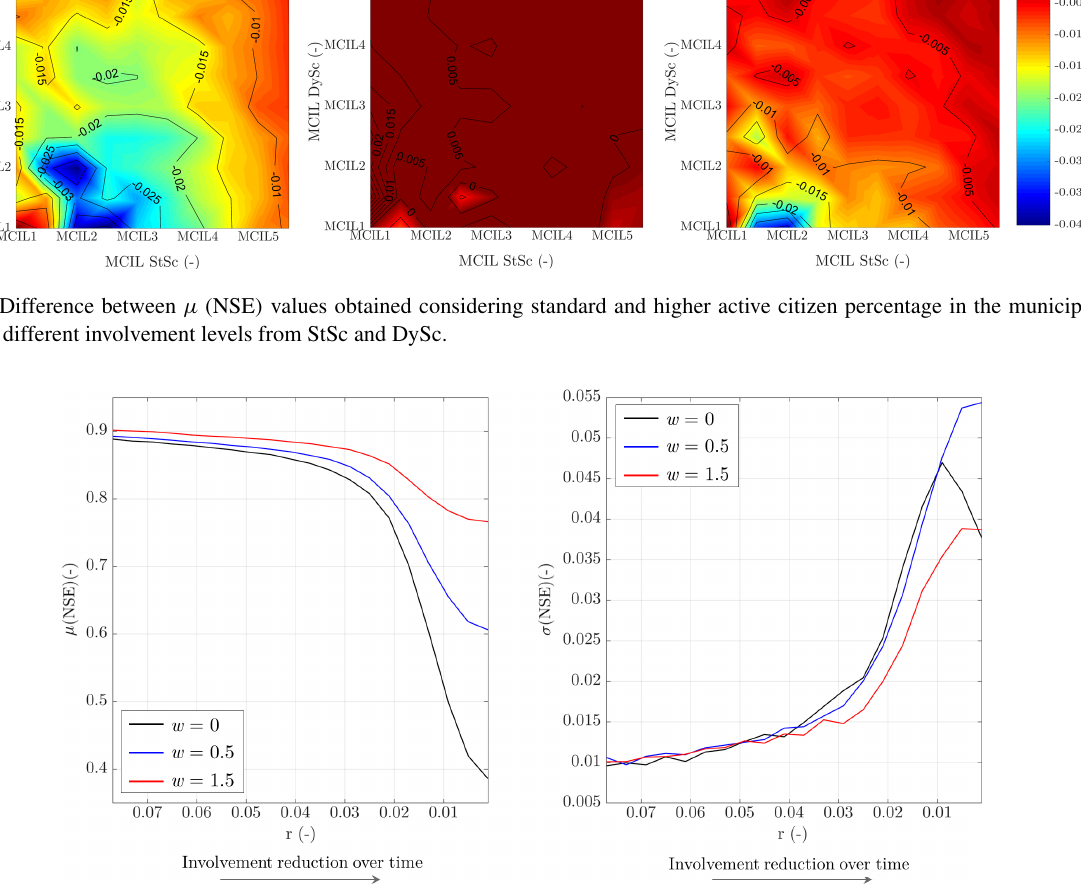
Figure 12. The µ ( NSE ) and σ ( NSE ) values obtained considering varying values of the coefficient r for scenarios 1 and 3 with three different values of w